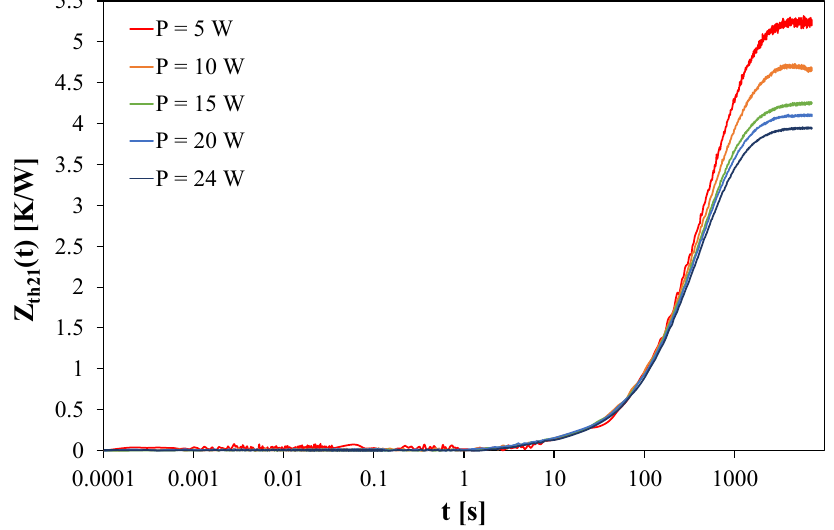
Figure 14. Mutual transient thermal impedance waveforms measured using v F as a TSP. The recording of Z th21 (t) waveforms allows for the analysis of delays in the heat flow in the tested system. As it is visible, the waveform starts after about 1 s from switching on the power dissipated in transistor M 1 . This is the time that is necessary for thermal